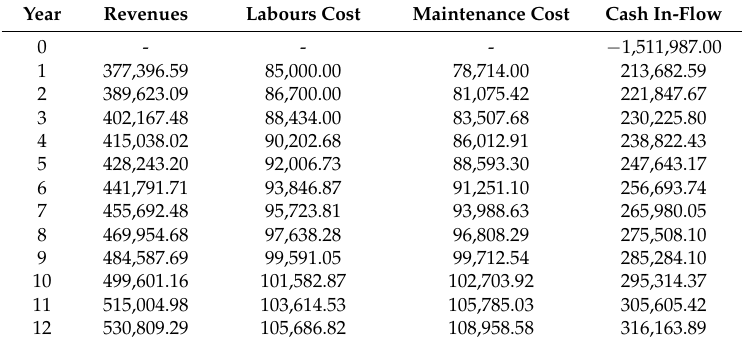
Table 4. Net flow derived from replacement of traditional illumination by LED.